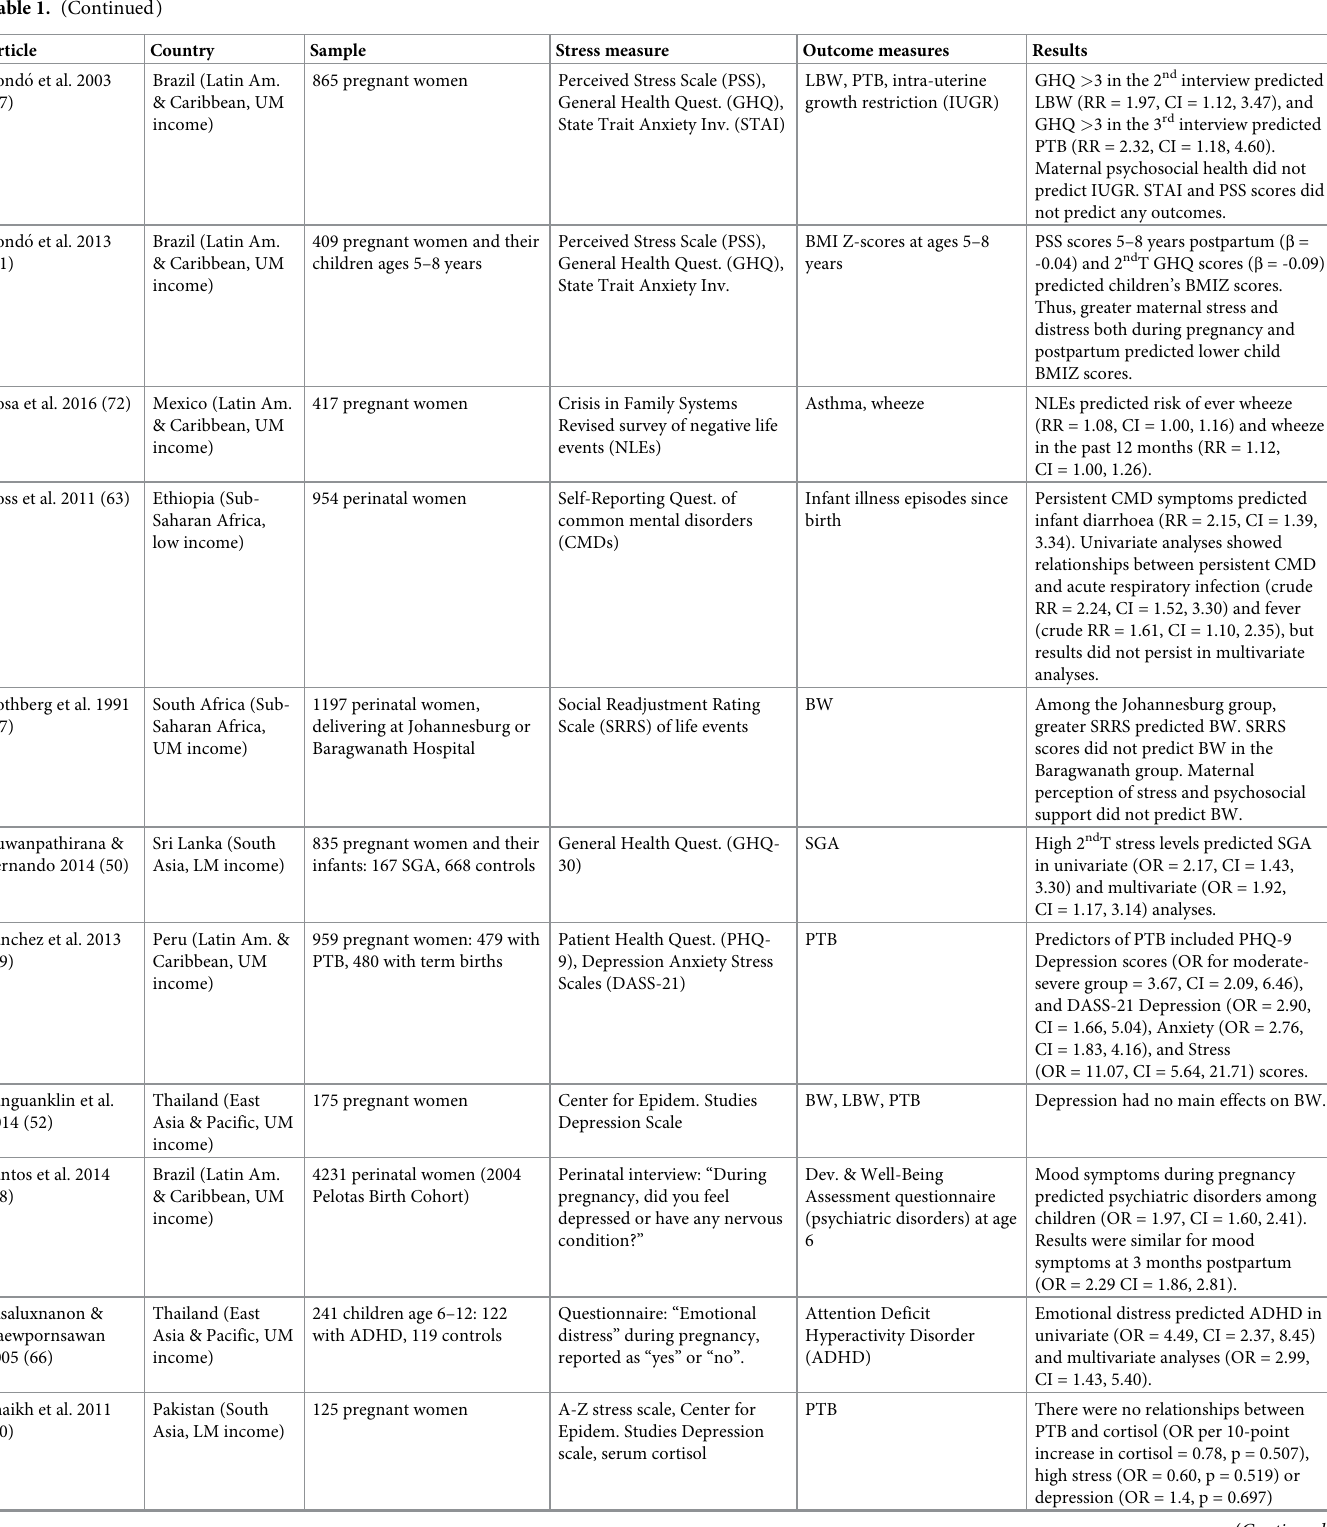
scores did not predict BW in the Baragwanath group. Maternal perception of stress and psychosocial support did not predict